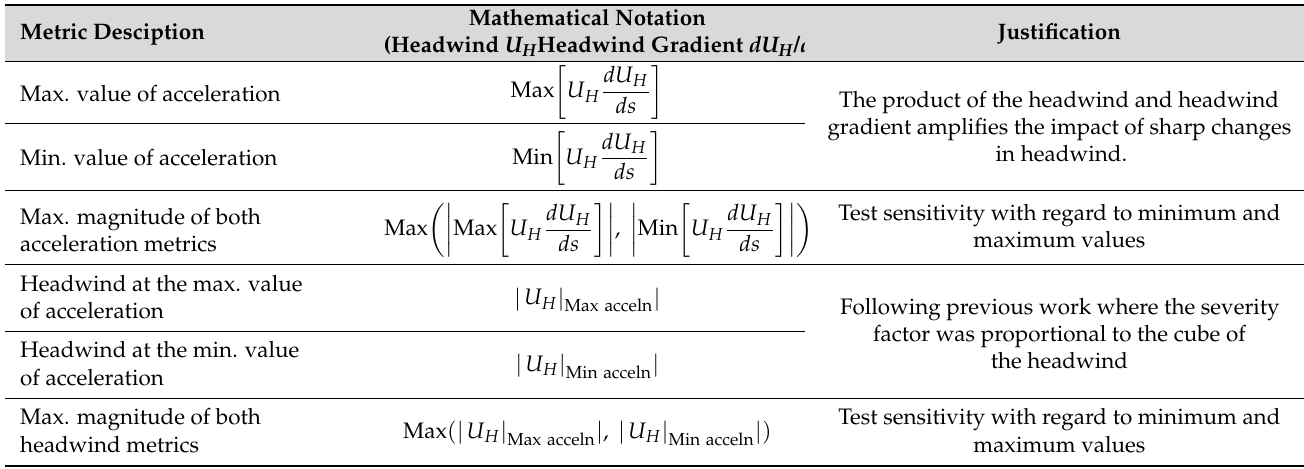
Table 2. Metric summary, including mathematical notation, and summary of justification for inclusion in the study; all metrics are calculated in both horizontal and vertical in relation to the 2D vertical slices aligned with the runways.